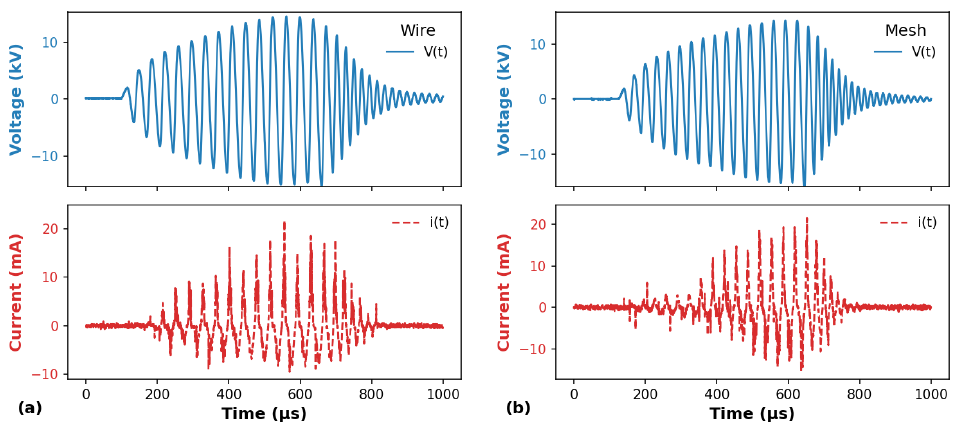
Figure 3. Typical waveforms of applied voltage (V(t)) and discharge current (i(t)) using ( a ) wire and ( b ) mesh configurations. The gas flow rate was 2.0 L/min in both